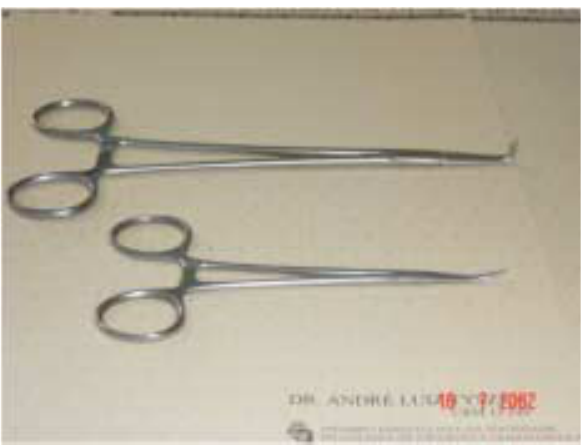
Fig. 1 – Photograph of the instruments used for the removal of the atherosclerotic